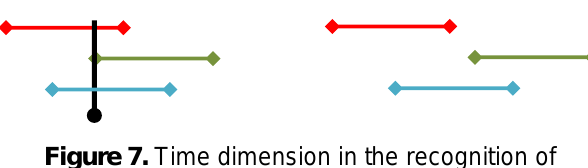
Figure 6. Applying the SMA algorithm.